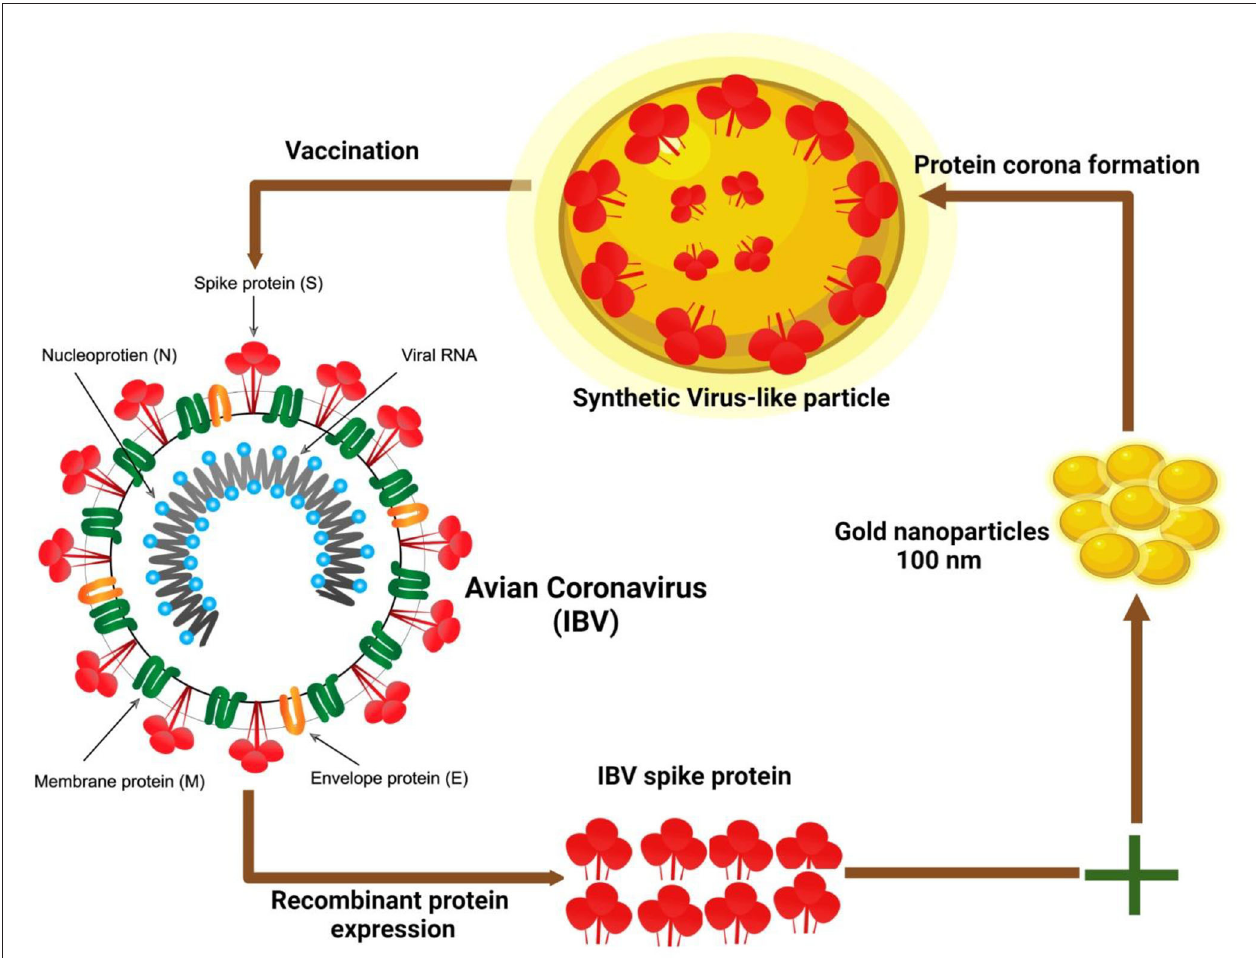
FIGURE 3 | Schematic illustration of the preparation of synthetic virus-like particles (sVLPs) of avian corona virus. sVLPs were prepared from optimized mix enclosing spike (S) protein of infectious bronchitis virus (IBV) and 100nm gold nanoparticles through impulsive development of corona protein